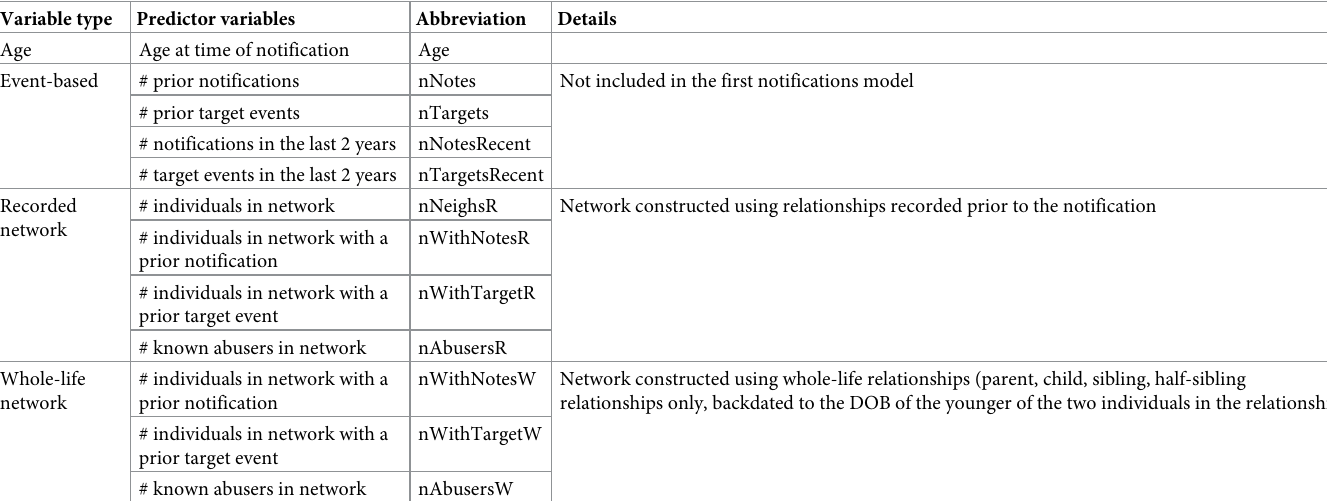
Table 1. Summary of predictor variables used in the statistical classification models. Event variables are the numbers of various types of event that occurred for the focal child prior to the notification. Recorded relationship variables are based on relationships recorded prior to the notification (see Fig 1A–1C); whole-life relationship variables are based on close family relationships, whether they were recorded before or after the notification (see Fig 1D–1F). A target event is defined to be a serious inter- vention by child protection services or a substantiated finding of maltreatment. Abbreviations are included for reference for Table 2 and Figs 1 and